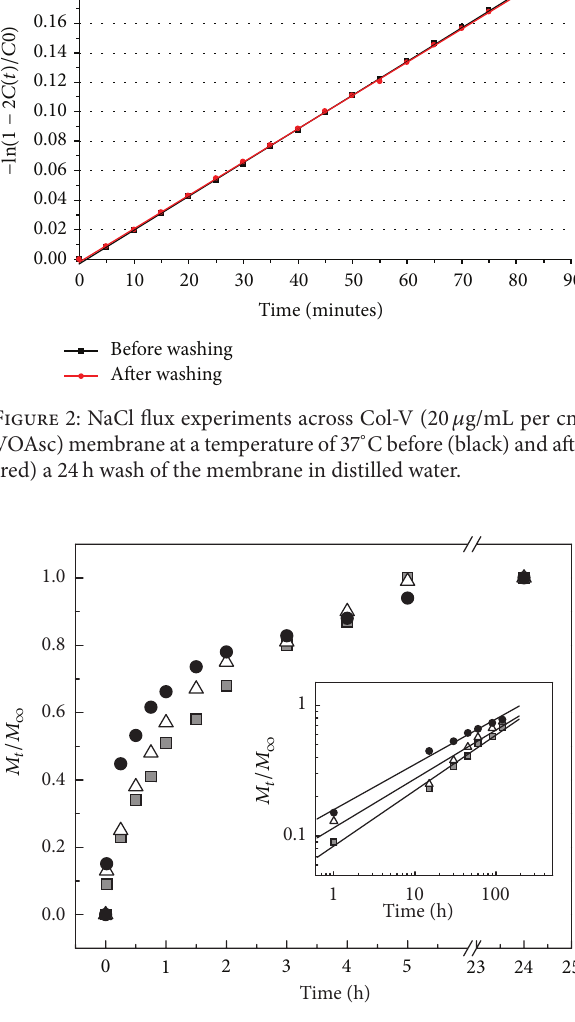
Figure 3: Fractional VOAsc drug release from the Col-V mem- branes in vitro. 𝐶1 : 10 𝜇 g/mL per cm 2 VOAsc; 𝐶2 : 20 𝜇 g/mL per cm 2